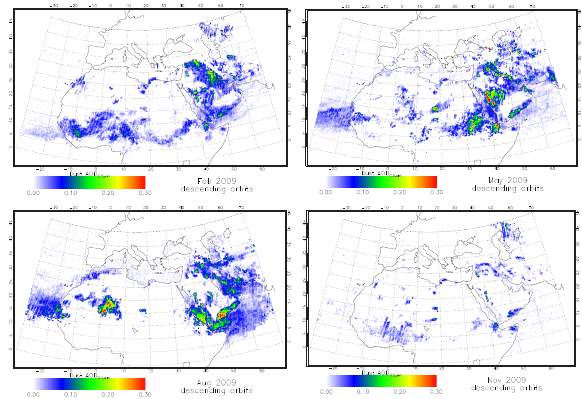
Fig.10. IASIDust AOD 0.5µm for February (top left), May (top right), August (bottom left) and November Fig. 10. IASI Dust AOD0.5µm for February (top left), May (top (bottomright)2009. right), August (bottom left) and November (bottom right)